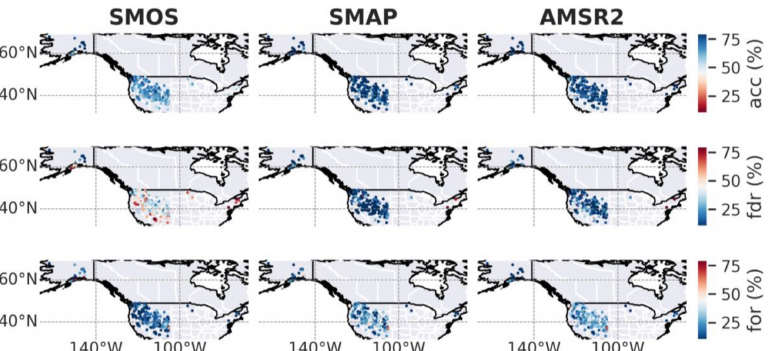
Figure 10. The false discovery rate (fdr), false omission rate (for), and accuracy (acc) of all SNOTEl and SCAN stations per SFI flag dataset for the period 2016–2019 and threshold t1 (SWE > 50 mm and / or TS <